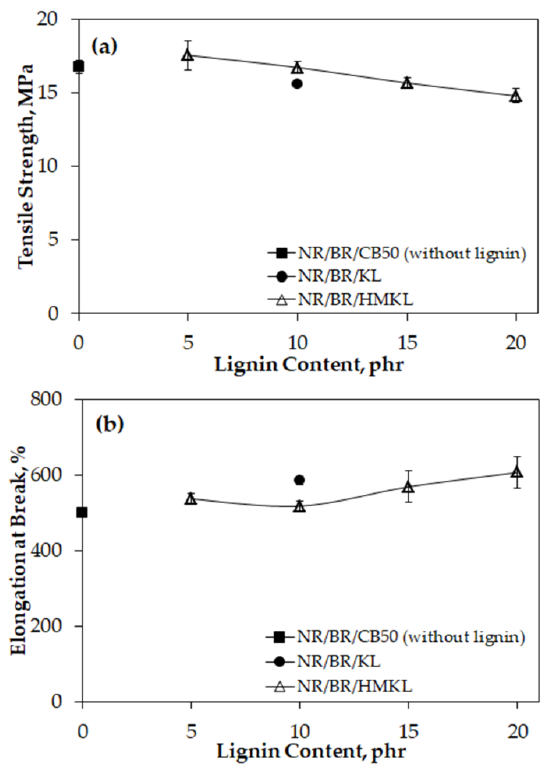
Figure 6. The effect of HMKL content on ( a ) tensile strength and ( b ) elongation at break, of lignin-filled NR/BR composites.